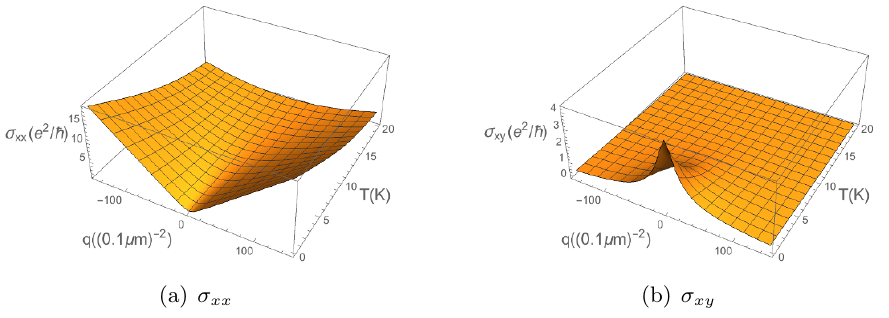
Figure 11 . The temperature and the charge density dependence of (a) the longitudinal conductivity (cid:27) xx and (b) the transverse conductivity (cid:27) xy